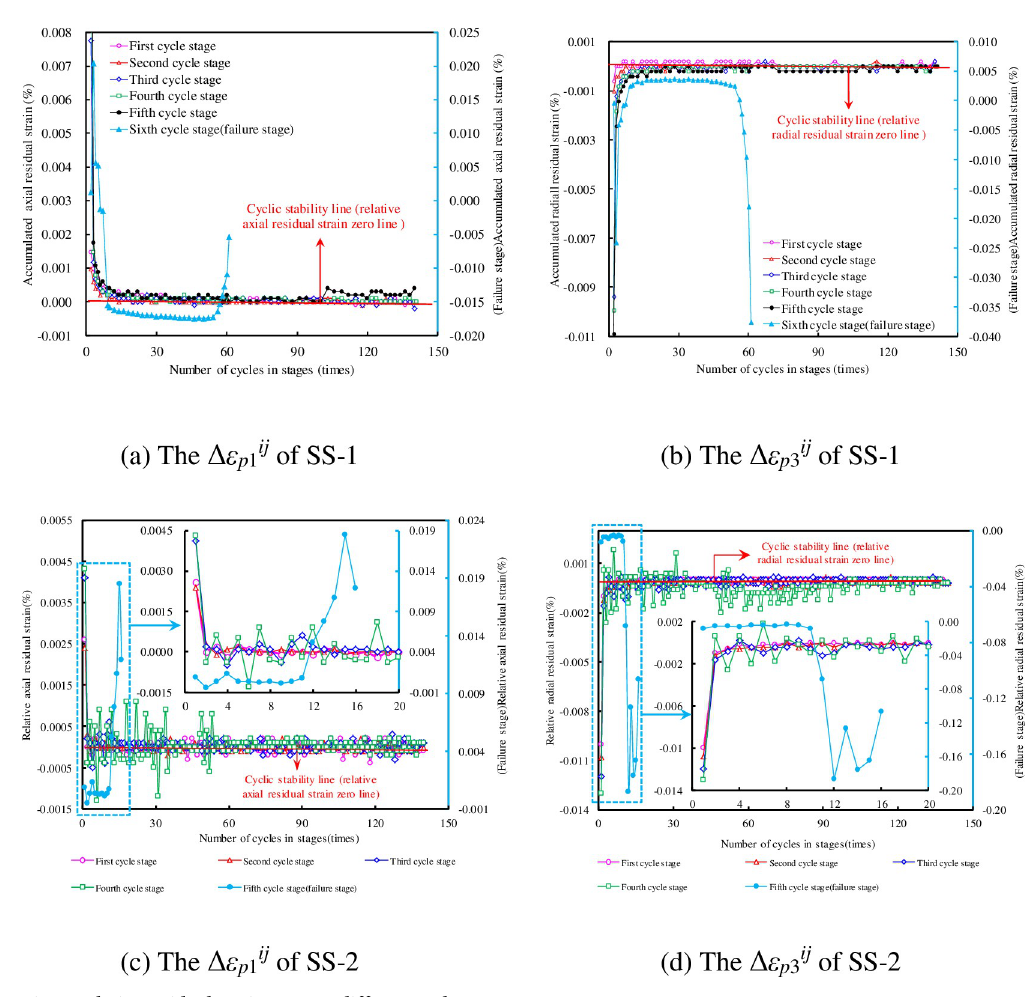
Fig 8. Relative residual strain curve at different cycle